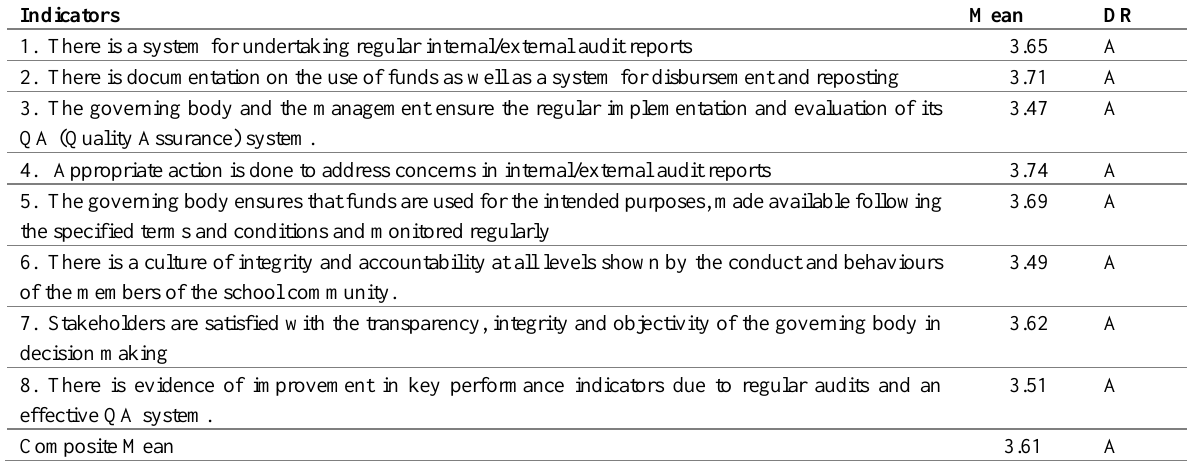
Table 3: Corporate Governance in terms of Accountability